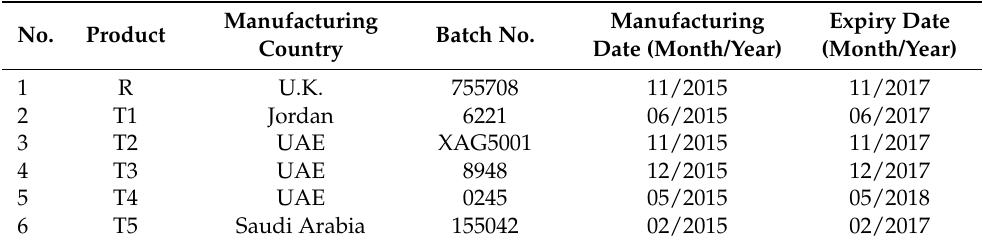
Table 1. Amoxicillin trihydrate/potassium clavulanate tablets (1 G) of different brands purchased from local UAE